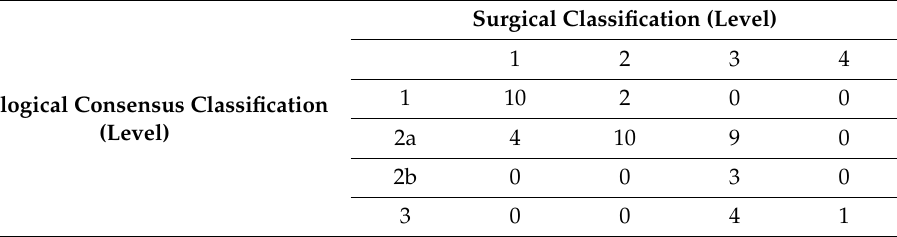
Table 2. Comparison of radiological versus surgical classification of the level of disease in patients with chronic thromboembolic pulmonary